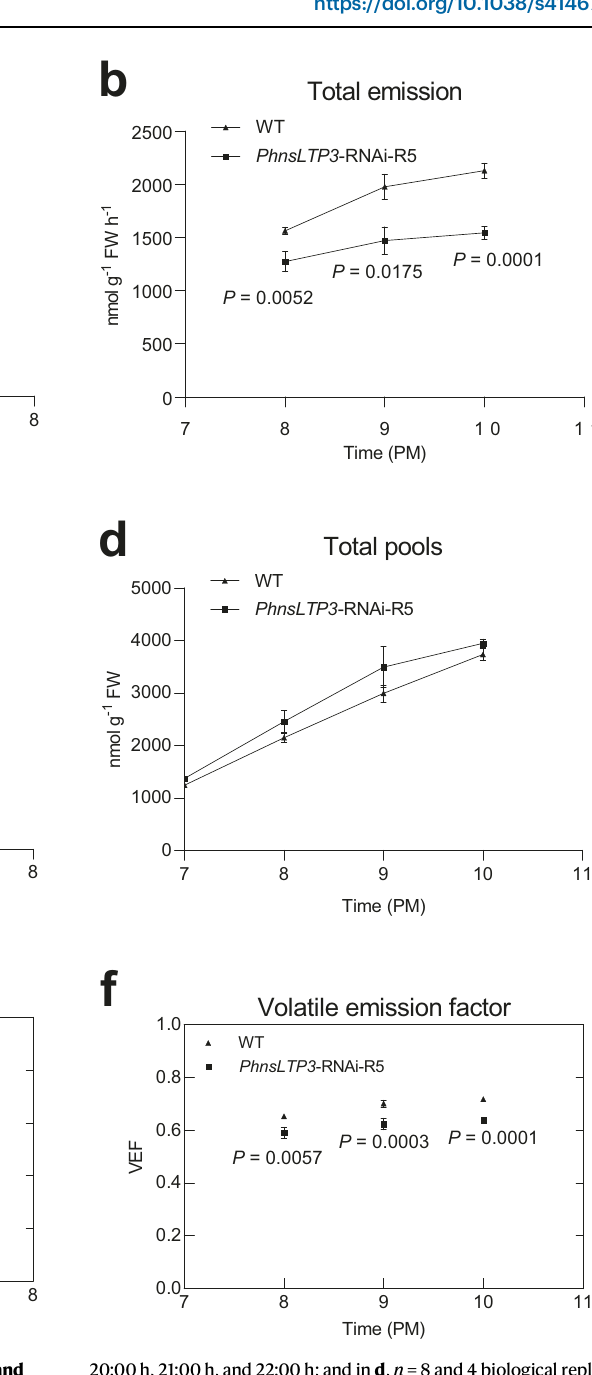
20:00h,21:00h,and22:00h;andin d , n =8and 4biologicalreplicatesforWTand PhnsLTP3 -RNAi-R5line,respectively,at19:00h. P -valuesweredeterminedbyatwo- tailed Student ’ s t -test for the emission and total pools between WT and PhnsLTP3 - RNAi-R5 line at each time point. In e , data are means±S.E. ( n =9 and 5 biological replicates for WT and PhnsLTP3 -RNAi-R5 line, respectively at 17:00h, 18:00h, and 19:00h). In f , data are means±S.E. ( n =8, 7 and 8 biological replicates for WT, and n =4, 5, and 5 biological replicates for PhnsLTP3 -RNAi-R5 line, respectively, at 20:00h, 21:00h, and 22:00h. In e and f , P -values were determined by two-way ANOVAwithSidak ’